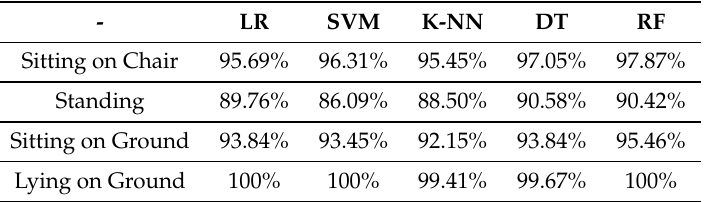
Table 16. Recall rate using different algorithms for three people.